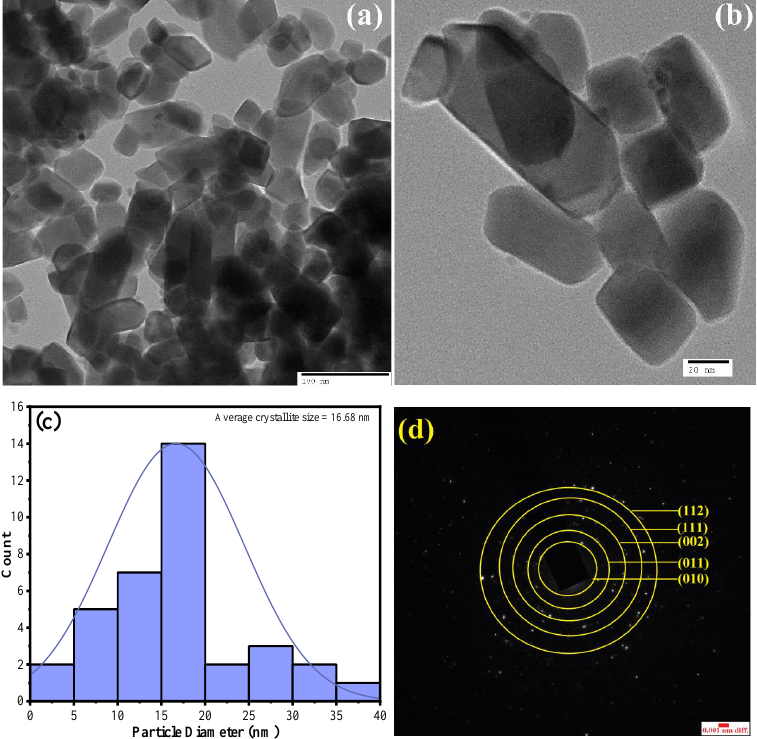
Figure 5. TEM images of ZnNiWO 4 NPs at ( a ) 100 nm, ( b ) 20 nm magnification, ( c ) Gaussian distribution of the particle size, and ( d ) SAED of ZnNiWO 4 NPs. PL measurements are an effective method to monitor the process of photo-induced electron recombination and transfer. The PL of the ZnWO 4 , NiWO 4, and ZnNiWO 4 NPs was tested under 320 nm excitation, and the luminescence spectrum (Figure 6) spanned the range from 400 nm to 700 nm, showing a prominent emission peak at 510 nm. As can be seen in Figure 6, the PL intensity of the ZnNiWO 4 NPs was lower than that of pure ZnWO 4 and NiWO 4 . Since zinc tungstate has a wolframite monoclinic crystal structure, the luminescence properties of this crystal were noticeably different from NiWO 4 . The mixing of Ni with ZnWO 4 resulted in emission associated with the radiative transitions between tungsten and oxygen within the (WO 6 ) 6− molecular complex followed by a charge transfer from Ni 2+ to Zn, which effectively suppressed the recombination of electron hole pairs [35].